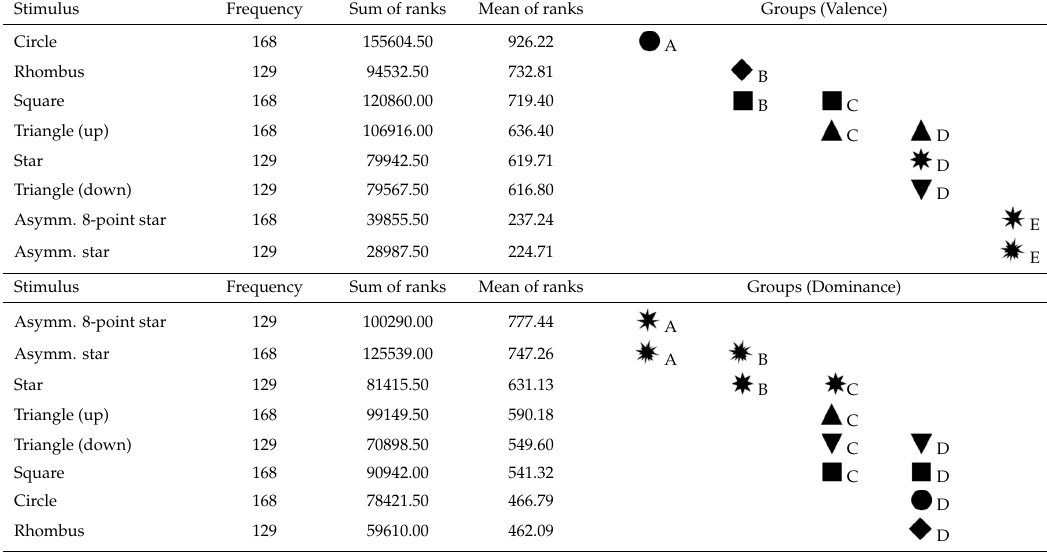
Table 2. Results of multiple pairwise comparisons of shape stimuli indicating groups of similar valence and dominance.